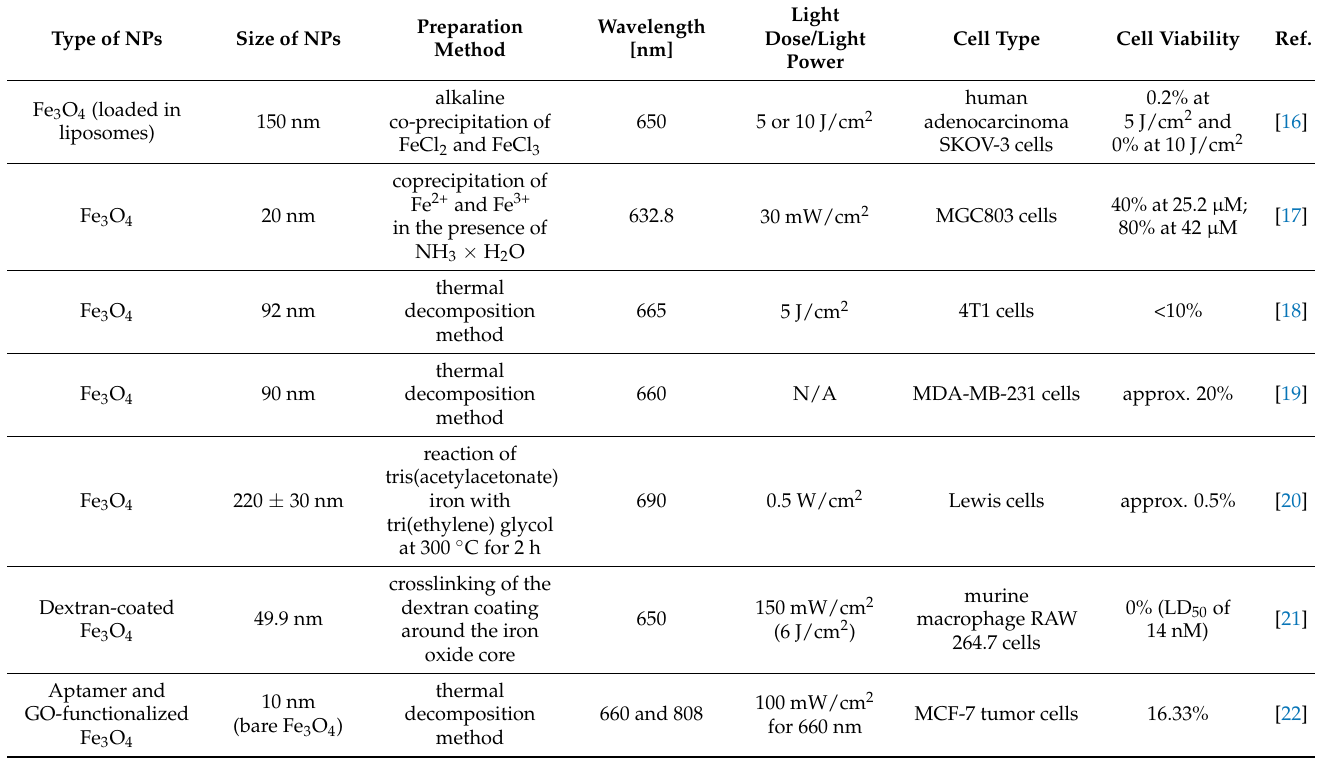
Table 1. A summary of the data presented in Section